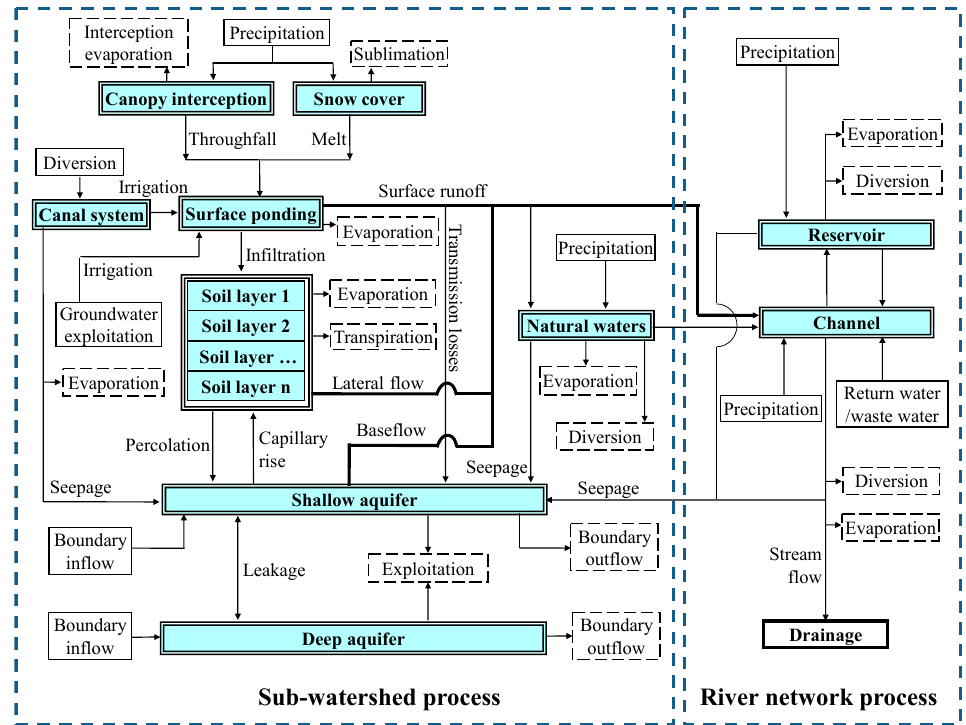
Figure 3. Hydrologic cycle framework of an object-oriented modularized model for basin-scale water cycle simulation (MODCYCLE).